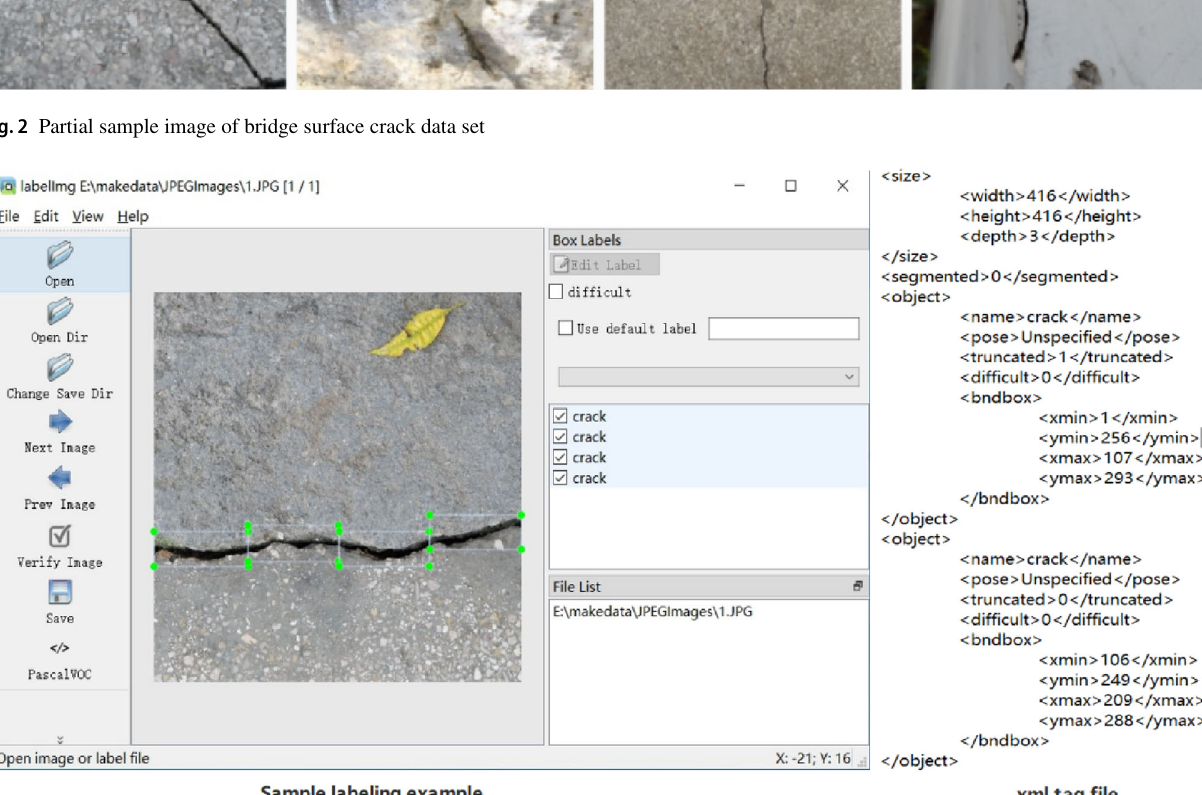
Fig. 3 Bridge surface crack image